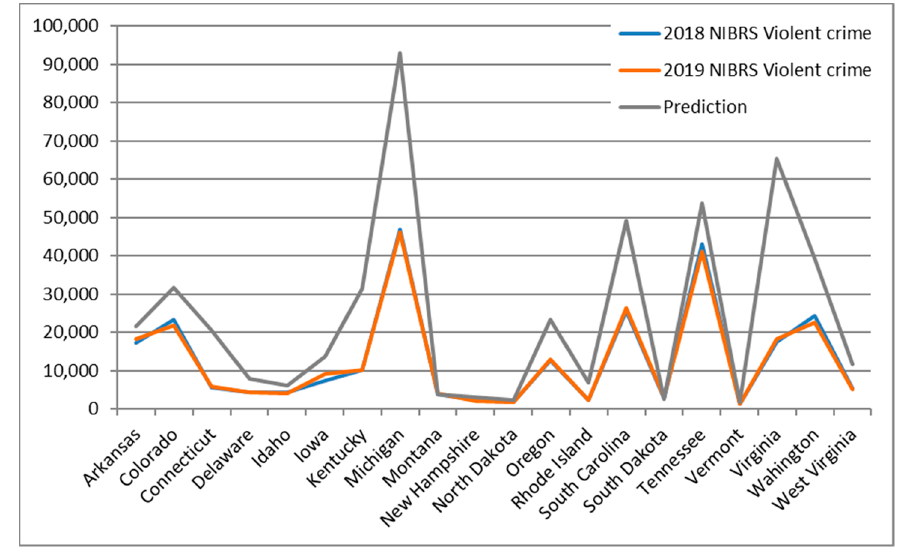
Figure 5. Comparison of the predicted crime occurrences against the NIBRS data at the state